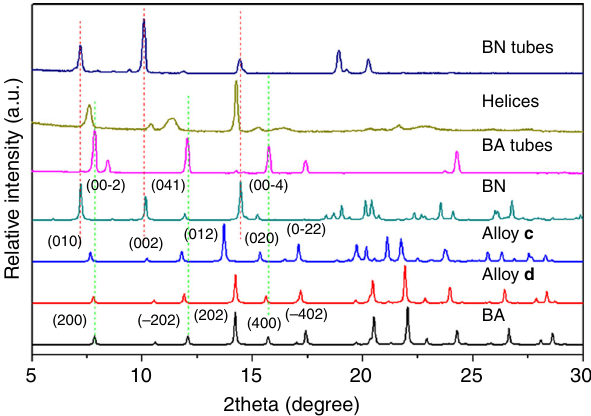
Fig. 2 XRD characterization of BA, BN, and BA/BN helical assemblies and the corresponding single crystals. Powder XRD patterns of BA tubes, BN tubes, and (BA) 0.72 (BN) 0.28 helices and simulated patterns from the single crystals of BA, BN, alloys c and d . The green and orange dashed lines represent the peaks of BA and BN, respectively